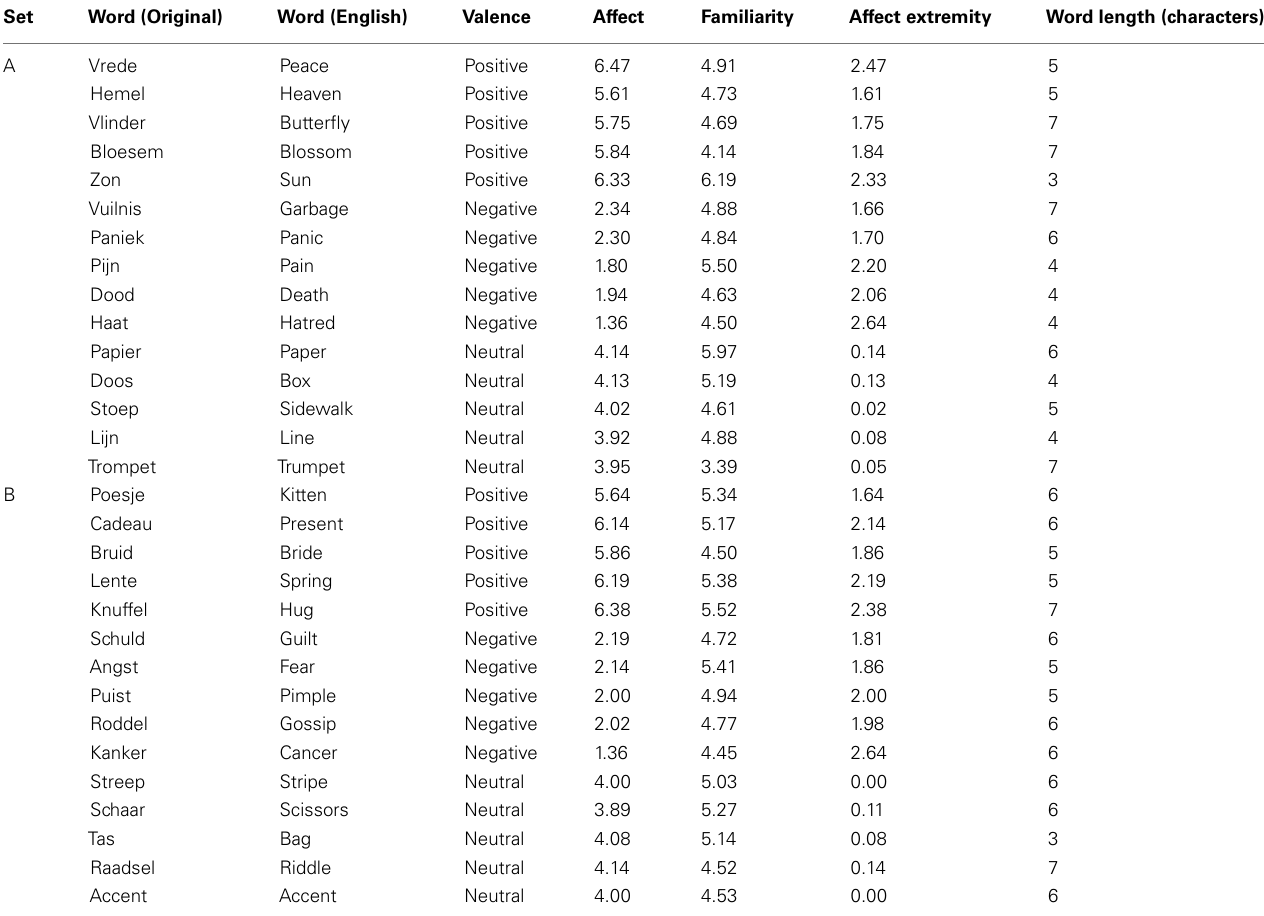
TableA2 |Valence category affect, affect extremity, familiarity, and word length of words used in the evaluative conditioning phase. Set